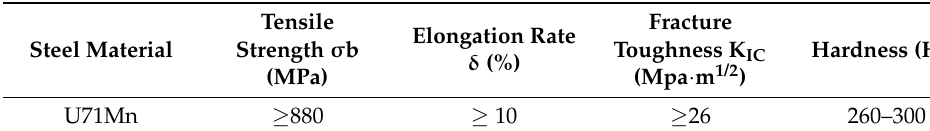
Table 2. Mechanical properties of U71Mn rail steel [27].